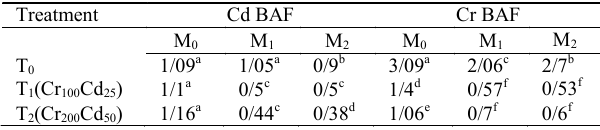
Treatments mean (n = 3). The same letters in each column showing no significant effect ( P<0.05 ), by Duncan’s test. M M : Humic 2